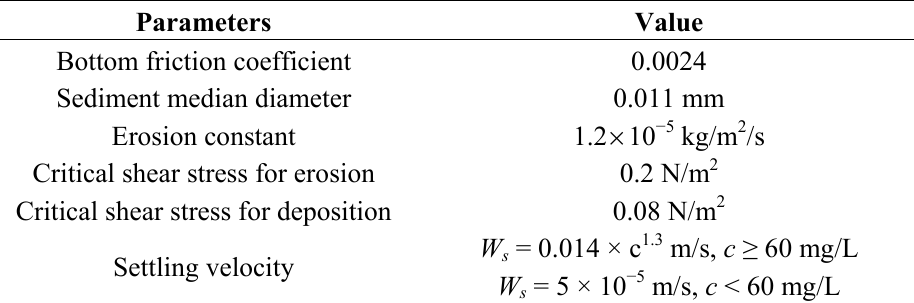
Table 2. Parameters used in the model of Deep Bay in the dry